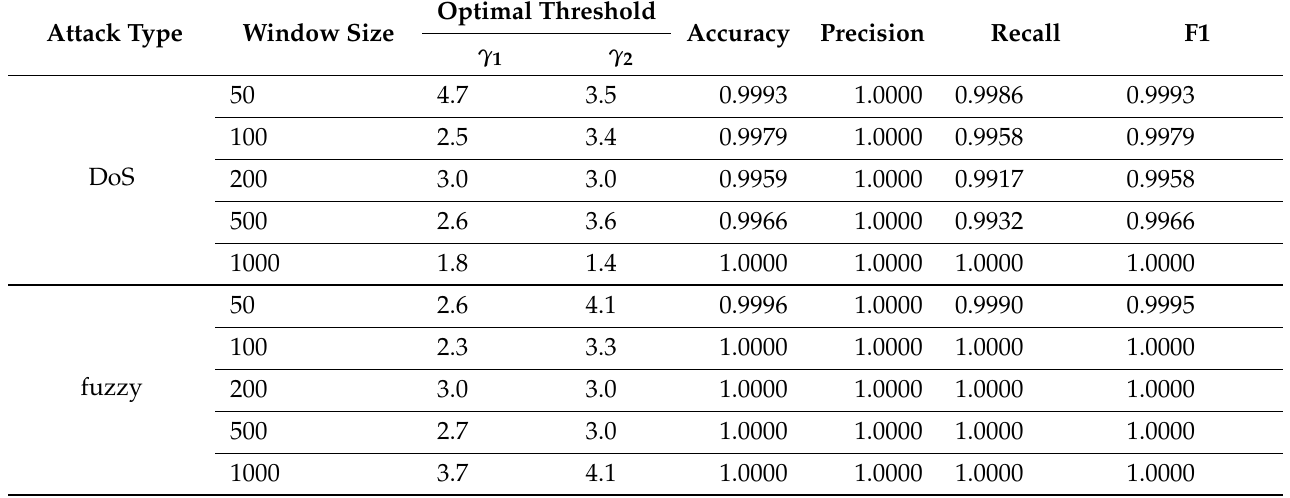
Table 14. Performance parameters for